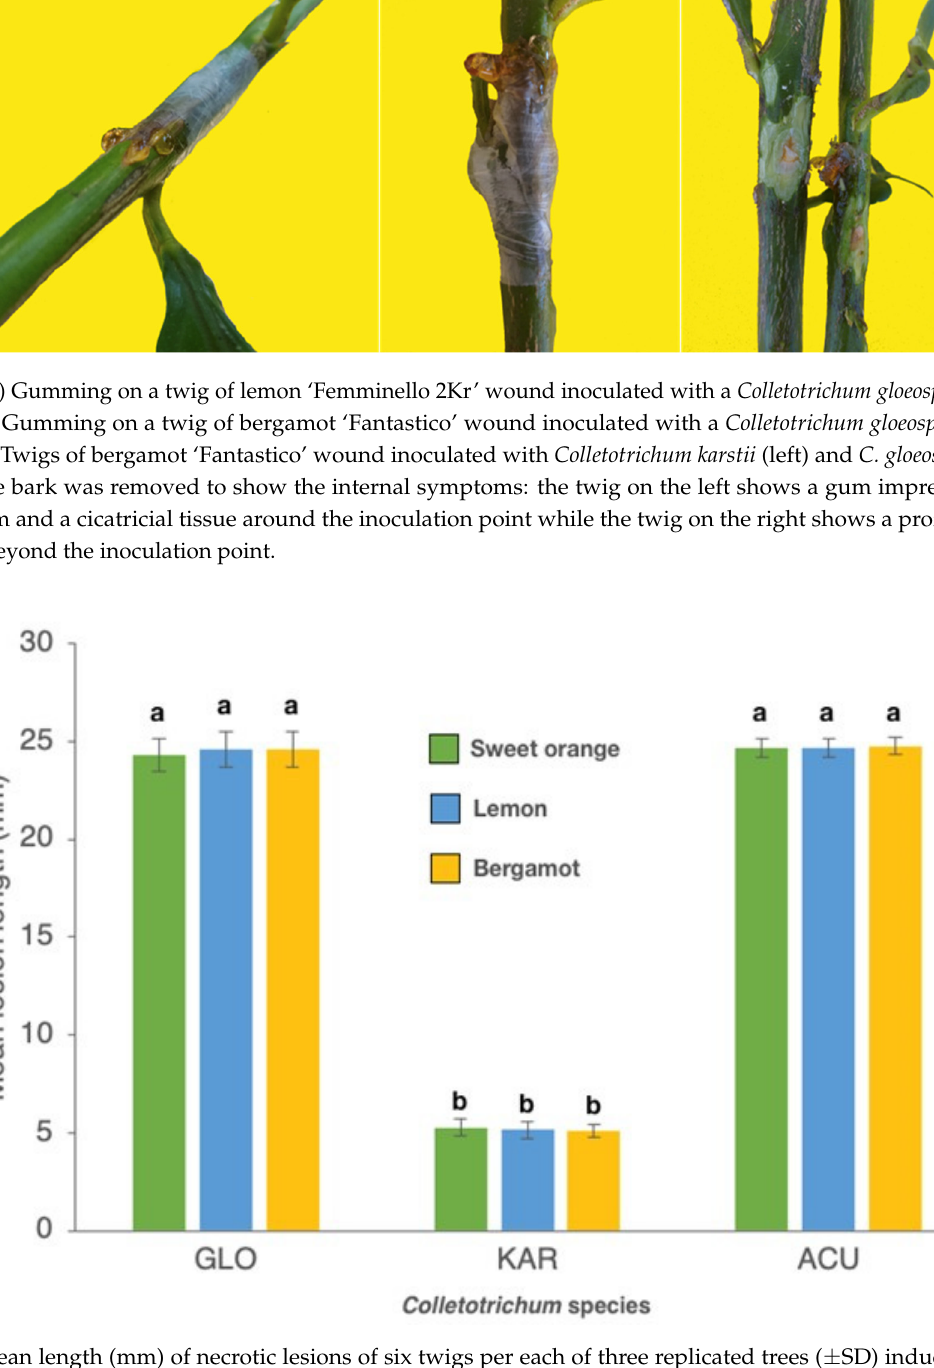
Figure 8. ( A ) Necrotic lesions around the inoculation point in a fruit of sweet orange “Tarocco Meli” wound inoculated with an isolate of Colletotrichum gloeosporioides 12 d.p.i.; the peel has been removed to show that the necrosis extends into the albedo. ( B ) Necrotic lesions around the inoculation point in a fruit of lemon “Femminello 2Kr” wound inoculated with an isolate of Colletotrichum gloeosporioides 12 d.p.i.; the peel has been removed to show that the necrosis extends into the albedo. ( C ) Aerial mycelium developed on the two inoculation points in a fruit of sweet orange “Tarocco Meli” wound